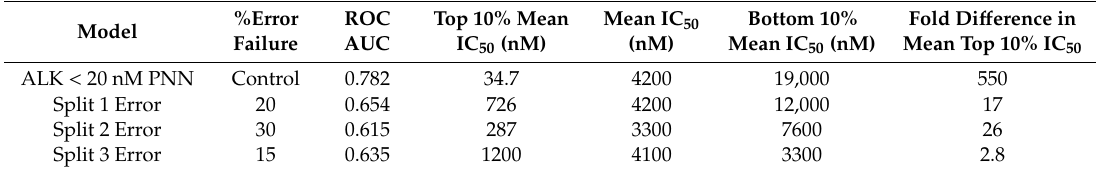
Table 7. Performance statistics for failed PNNs generated with the specified error in each split.